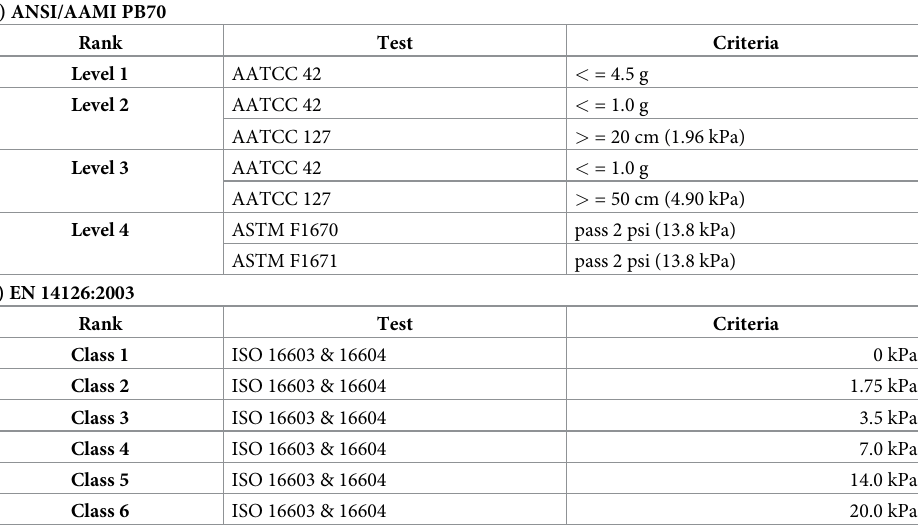
Table 1. American National Standards Institute (ANSI) / Association for the Advancement of Medical Instru- mentation (AAMI) PB70 liquid barrier performance and classification (A) and European Standards (EN) perfor- mance requirements